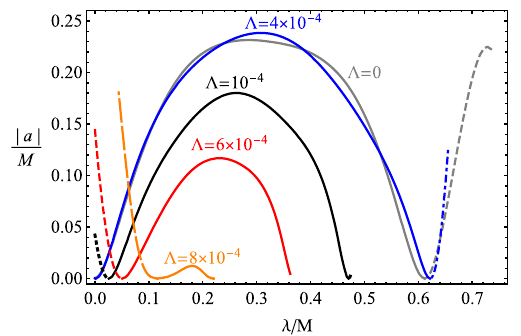
Fig. 6 The radial dependence of LE for the motion of test particles around the Schwarzschild black hole surrounded by PFDM medium in a de Sitter spacetime for different values of the cosmological constant Λ and the parameter λ . In this plot we use Λ → Λ/ M 2 and λ → λ/ M